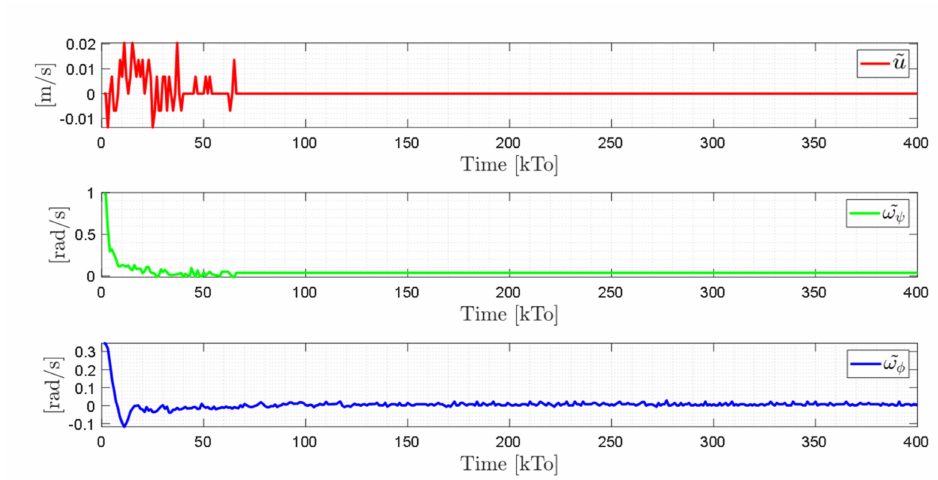
Figure 18. Time evolution of the control errors ˜ µ ( kT 0 ) = ( ˜ µ , ˜ ω ψ , ˜ ω φ ).